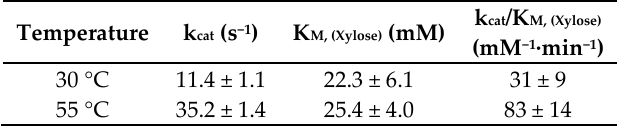
Table 2. Kinetic parameters of the xylose reductase from C. thermophilum . d-Xylose (varied between 0.001–0.5